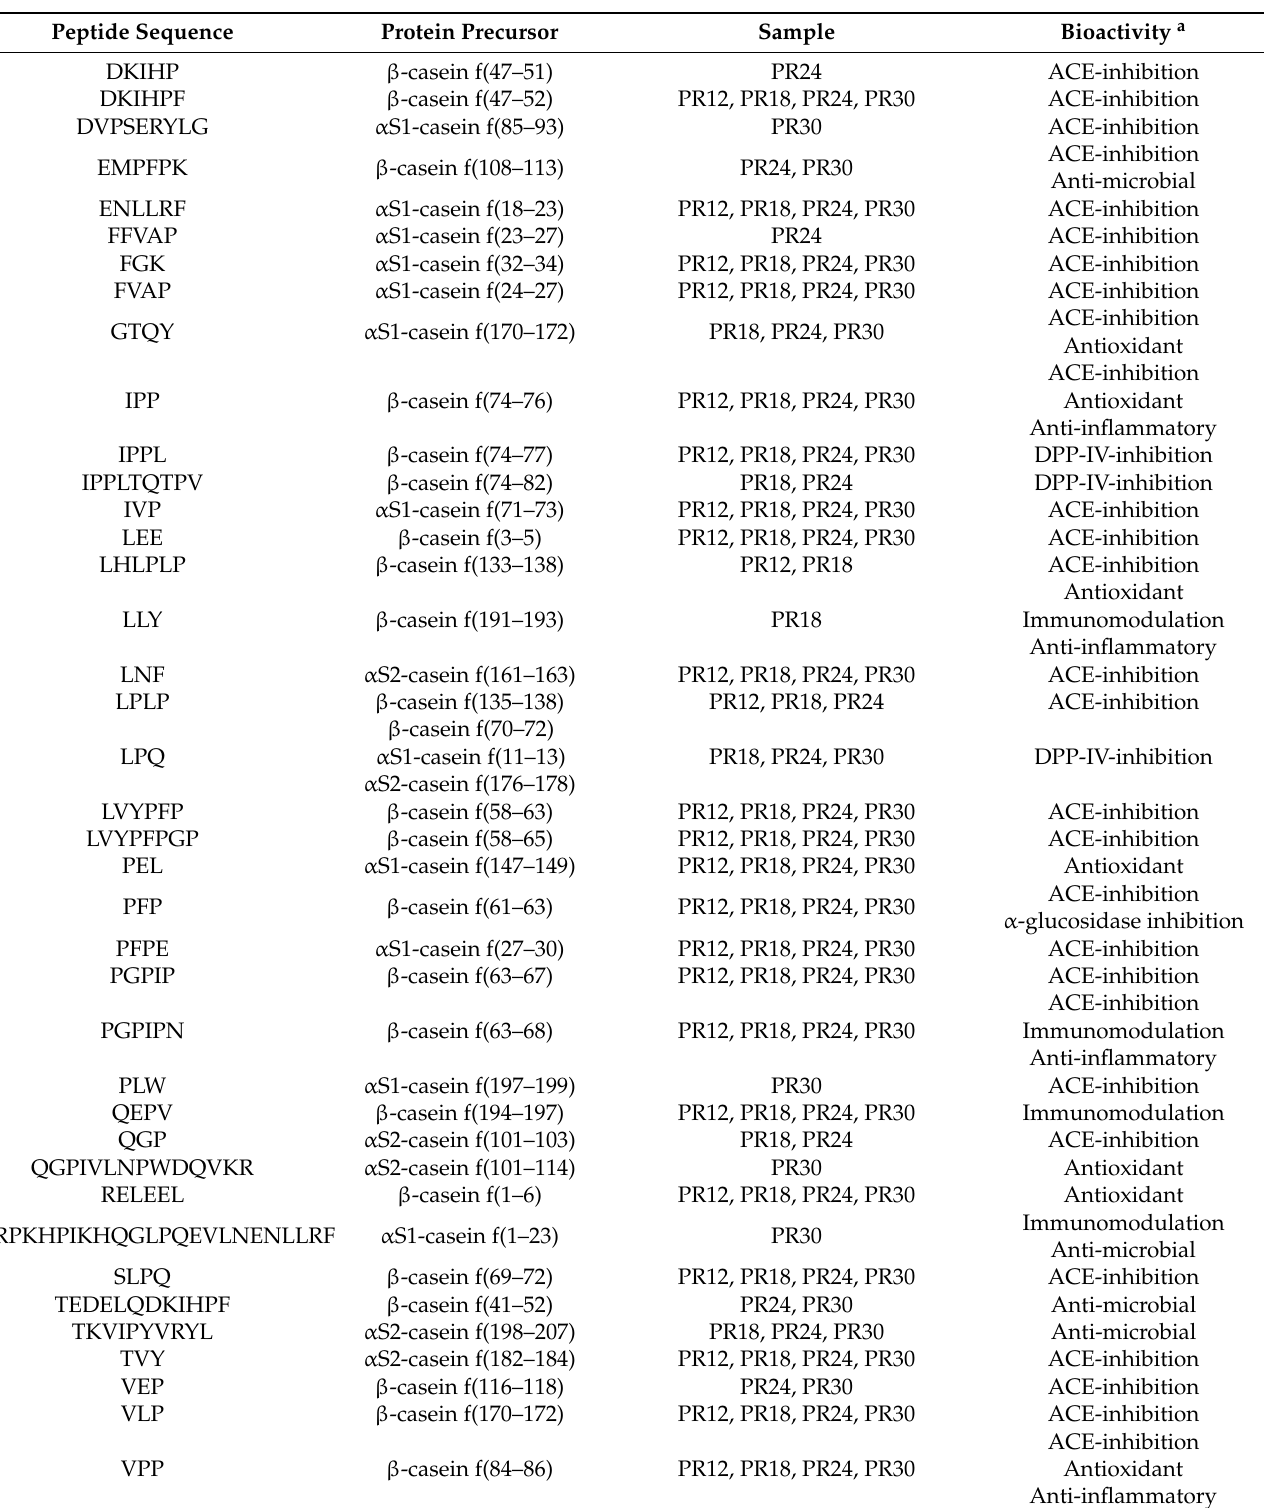
Table 1. Peptides with previously reported biological activity identified in water-soluble low-molecular weight peptide extracts from Parmigiano-Reggiano (PR) at different ripening